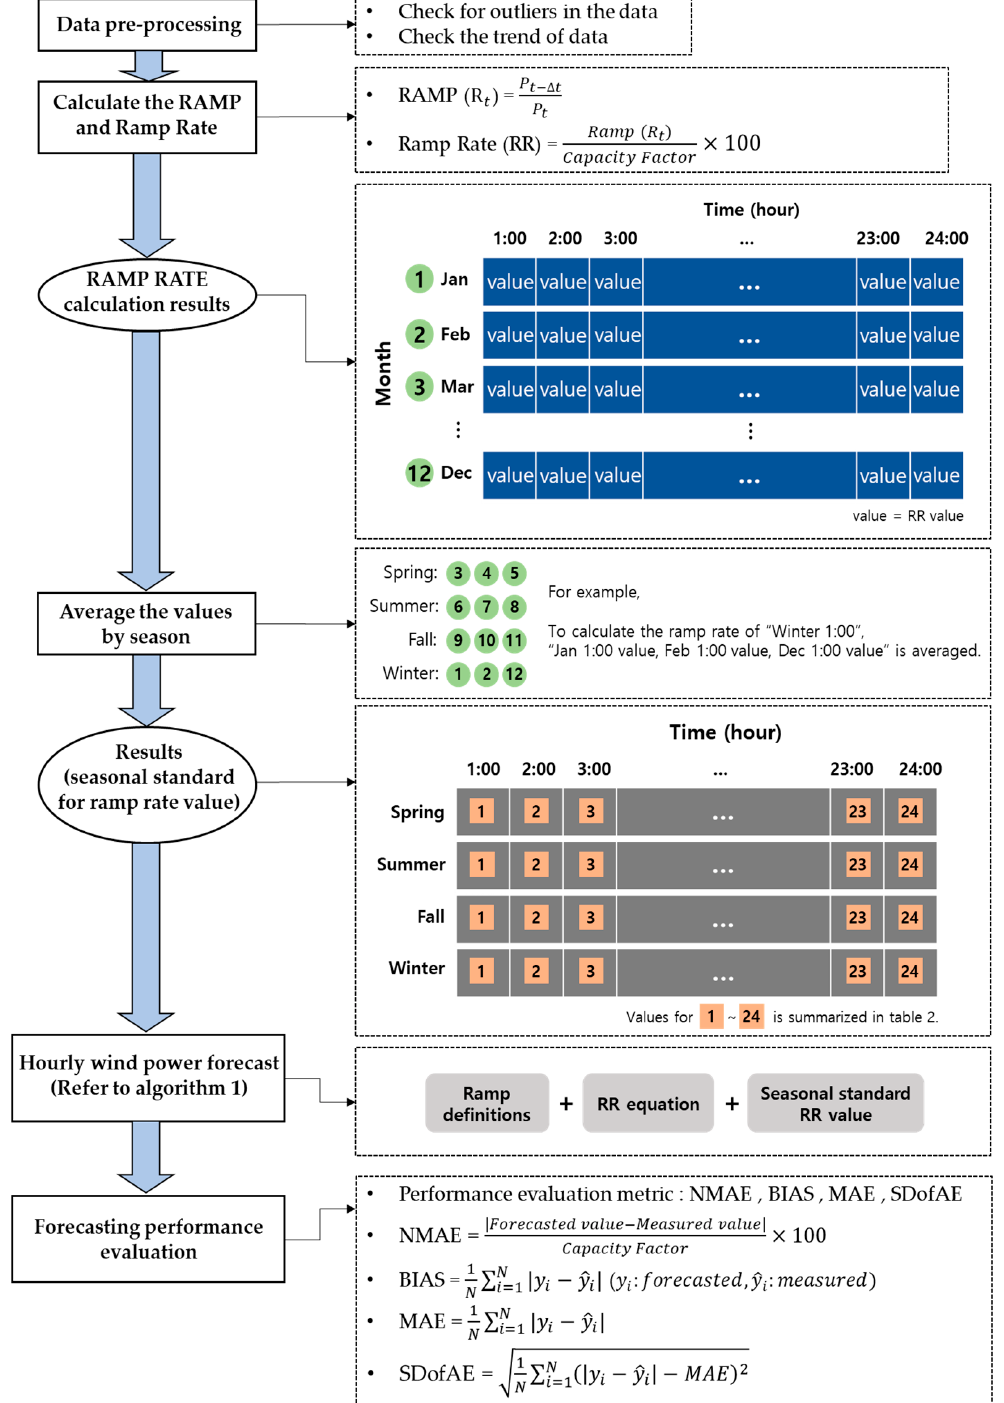
Figure 4. The main algorithm of this study.